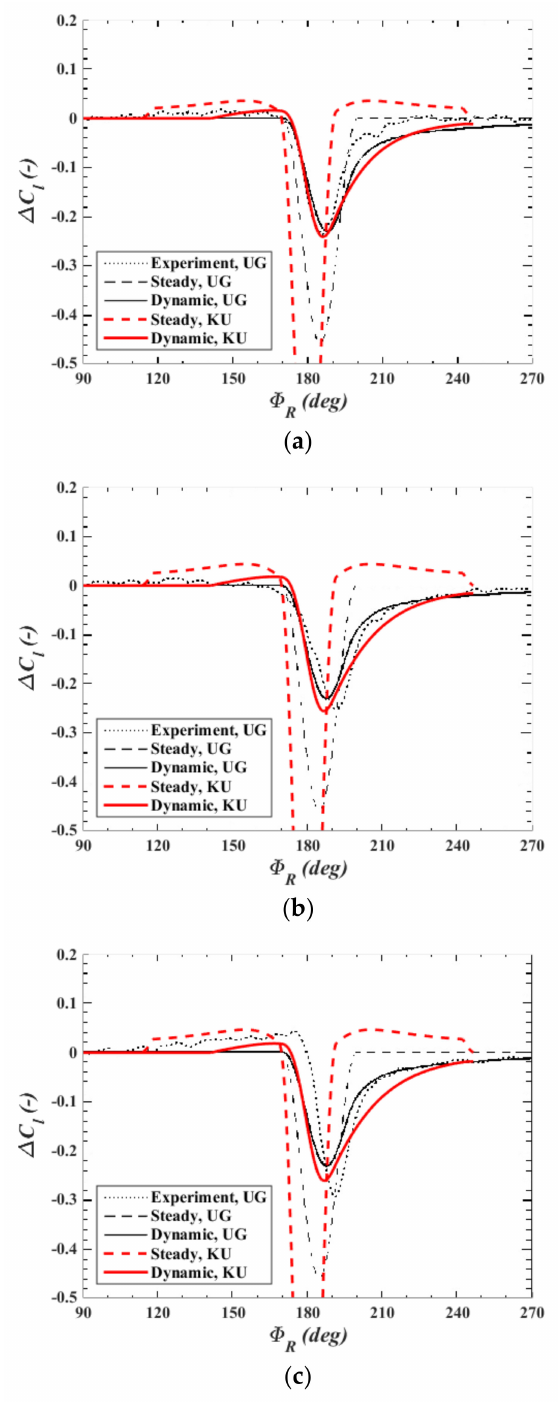
Figure 13. Deviations in the lift coe ffi cient at blade η B = 75 % according to 2 % of the dead band, C d = 1.2 [24]: ( a ) Case 1: V T = 36.0 m / s; ( b ) Case 2: V T = 44.1 m / s; ( c ) Case 3: V T = 46.7 m /